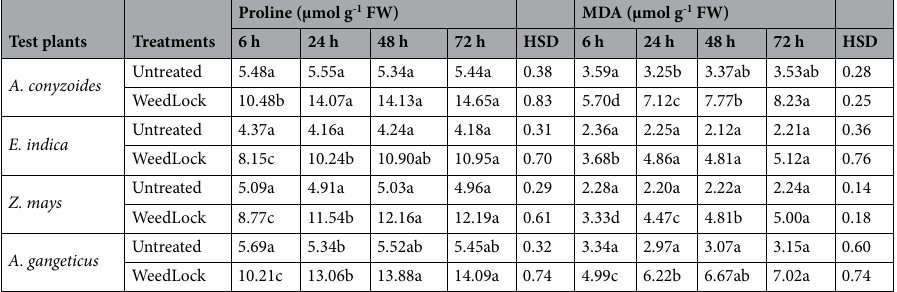
Table 3. Effect of WeedLock on proline and MDA content of test plants. Means having different letters differ significantly at p < 0.05.